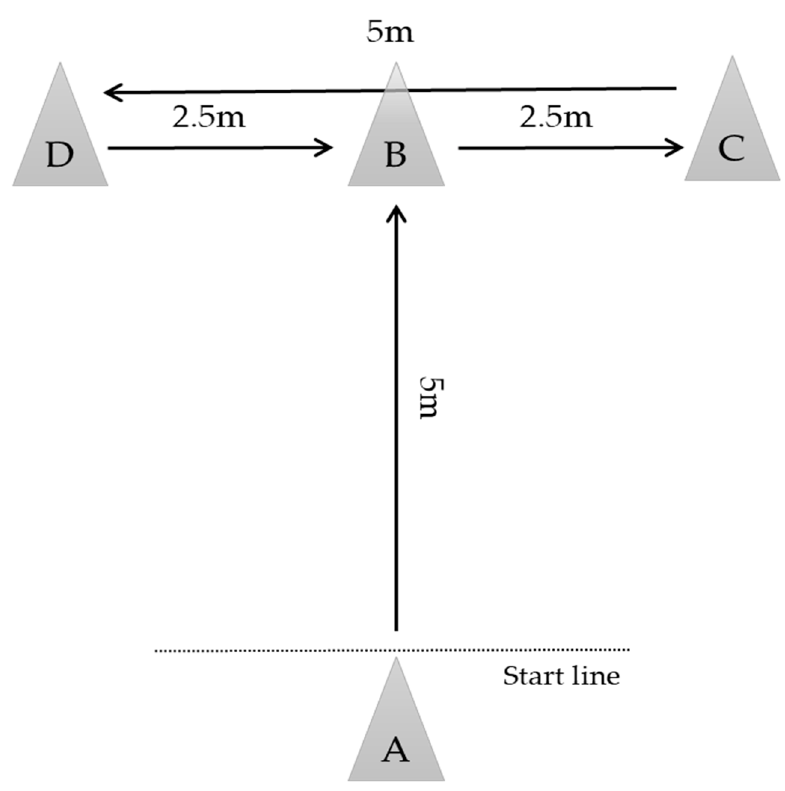
Figure 1. Repeated change of direction